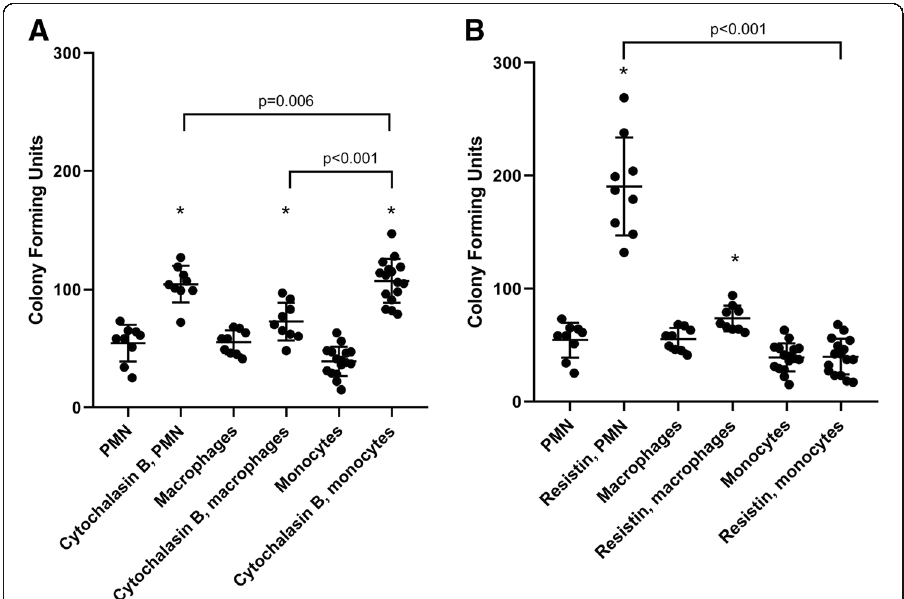
Fig. 1 Comparison of bacterial killing of P. aeruginosa by PMN (neutrophils), macrophages, and monocytes in the presence of a cytochalasin B and b human resistin. Cytochalasin B significantly impaired the ability of all cell types to kill P. aeruginosa ( P <0.001 for PMN, P =0.002 for macrophages, P <0.001 for monocytes), underlying the importance of F-actin in the bactericidal process. Resistin significantly impaired bacterial killing of P. aeruginosa in neutrophils ( P <0.001) and macrophages ( P <0.001) but not in monocytes ( P >0.99). n =18 (PMN), 9 (macrophages), and 16 (monocytes). Statistically significant differences in bacterial killing capacity between different cell types to each stimulant are denoted by P values on the graph. Asterisk denotes statistical significance ( P